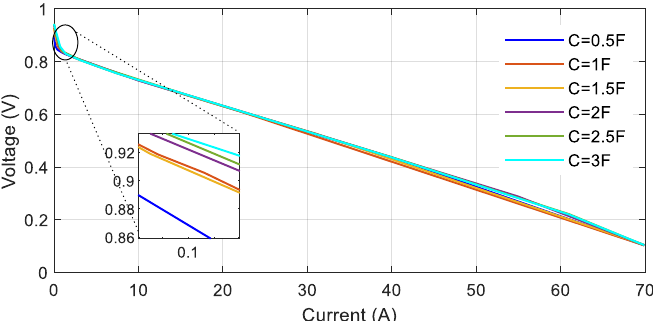
Figure 3. Polarization curves for effect of double layer capacitance on micro-structured electrode scaffold (MES) PEFMC.